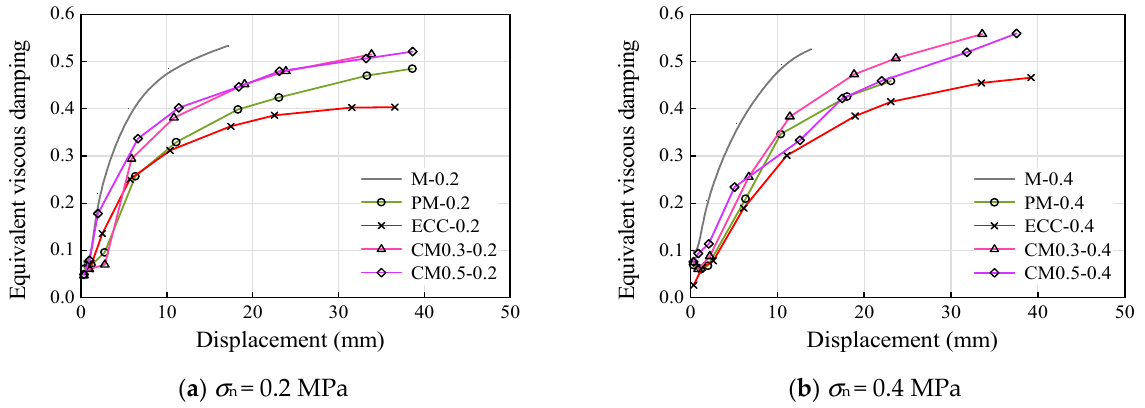
Figure 16. Equivalent viscous damping: ( a ) σ n = 0.2 MPa and ( b ) σ n = 0.4 MPa.